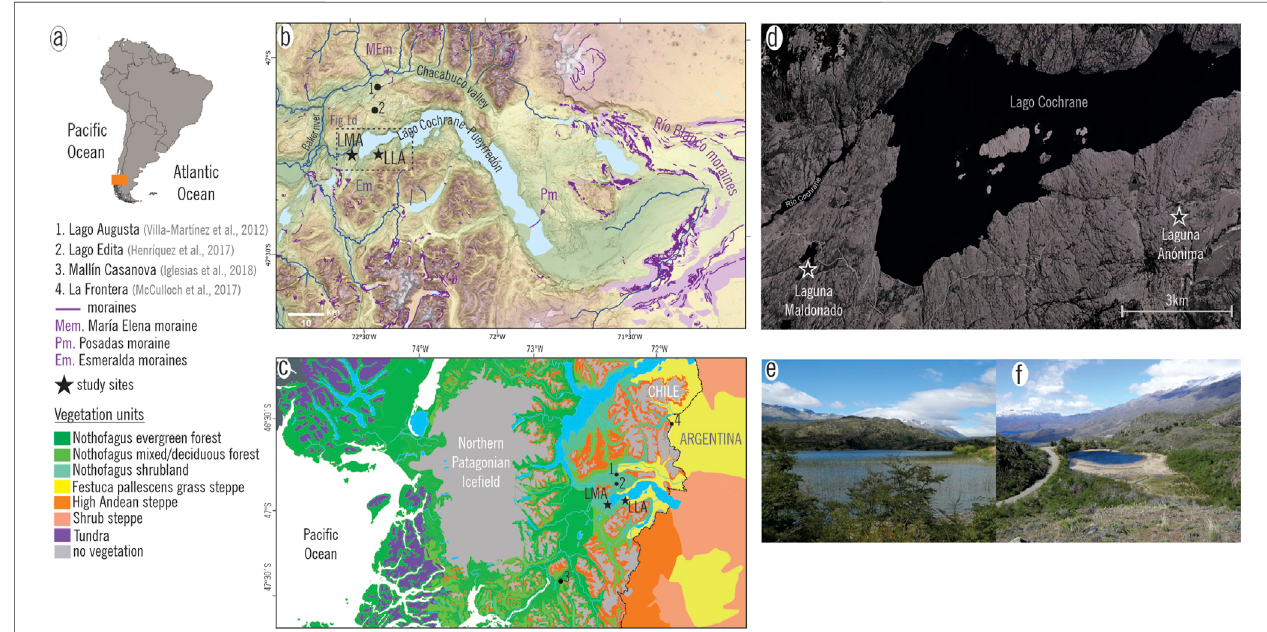
FIGURE 1 | (A) Map of South America showing the study area location; (B) digital elevation model (DEM) showing the location of Laguna Maldonado (LMA) and Laguna Anónima (LLA), main glacial geomorphological features (moraines; modi fi ed from Bendle et al., 2017; Thorndycraft et al., 2019; Davies et al., 2018, 2020), and sitesmentionedinthetext; (C) vegetationmap(takenfromLuebertandPliscoff,2017)showingthesteepwest – eastgradientandthelocationsofthepaleoenvironmental recordsreportedinthispaperandpreviouslypublished; (D) satelliteimage ofthewesternand southerncoasts ofLagoCochrane showingthelocationofLMAand LLA; photographs of (E) LMA and (F) LLA.